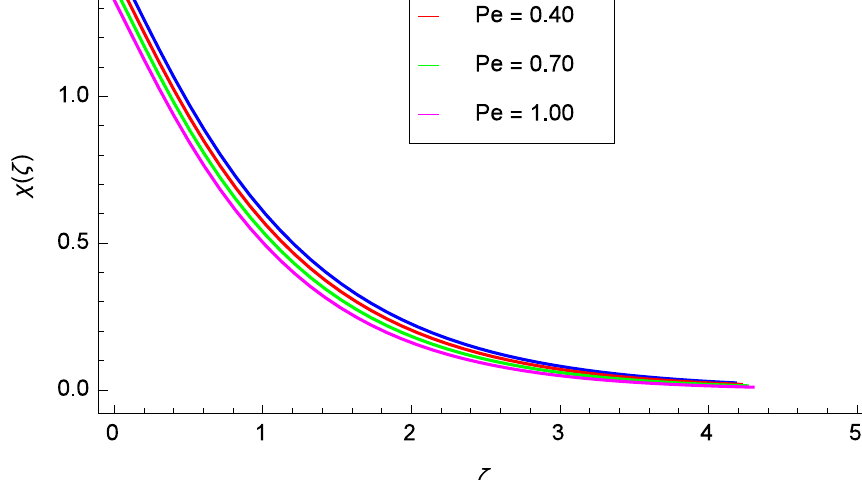
Figure 21. Influence of Pe on χ ( ζ ) .